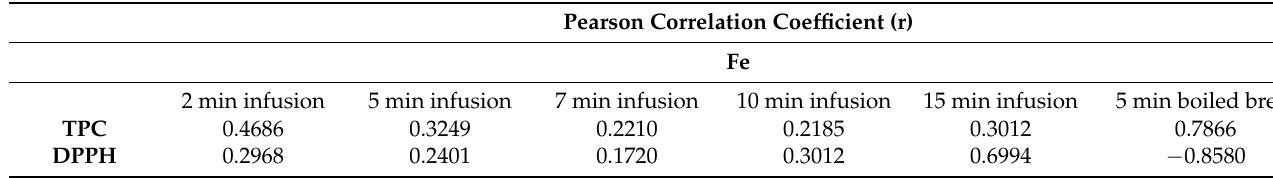
Table 9. Correlation coefficient of antioxidant activity and Fe in digested leaves. Pearson Correlation Coefficient